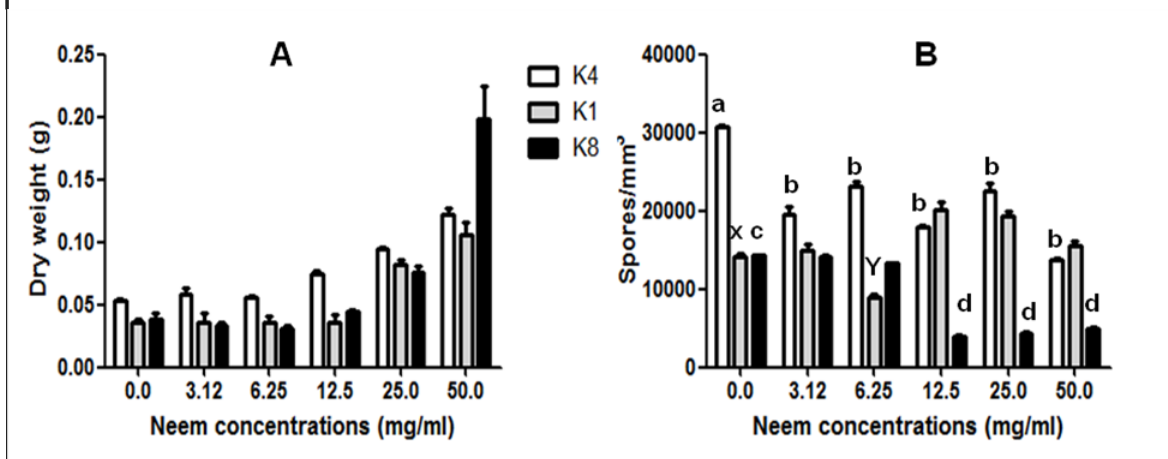
Figure 1. Effect of NLE added on PD medium on dry weight (A) and on spore numbers (B) of P citrinum (isolates K1, K4 and K8). Bars indicate standard deviation for experiments carried out in four replicates. Different small letters over the columns indicate statistically significant differences ( p<0.05 ) for K4 spore numbers (a, b), K1 spore numbers (x, y) and K8 spore numbers (c,